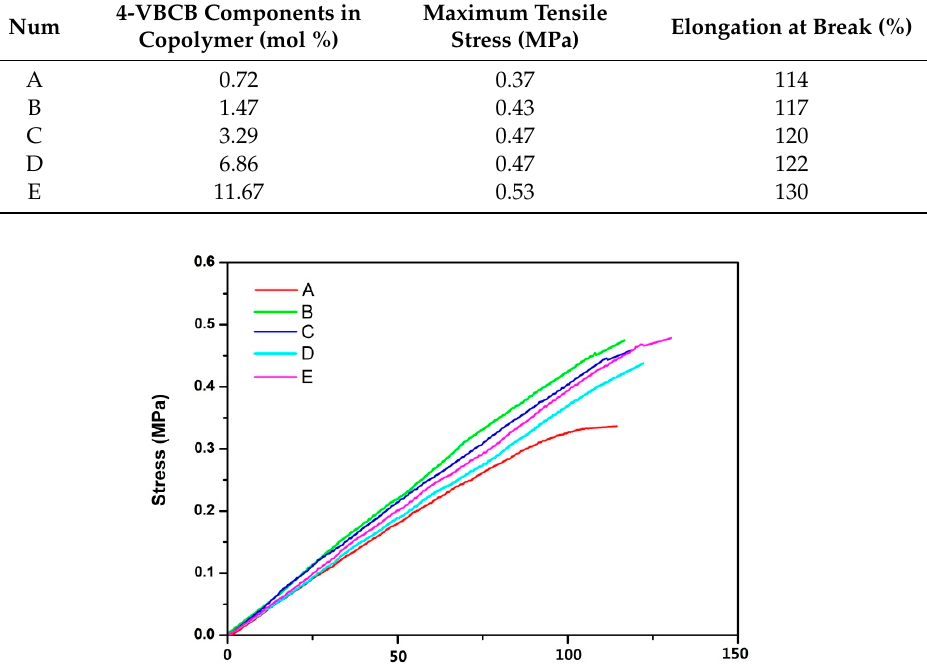
Table 4. Stress-strain behavior of poly(IB- co -4-VBCB) after thermal crosslinking.